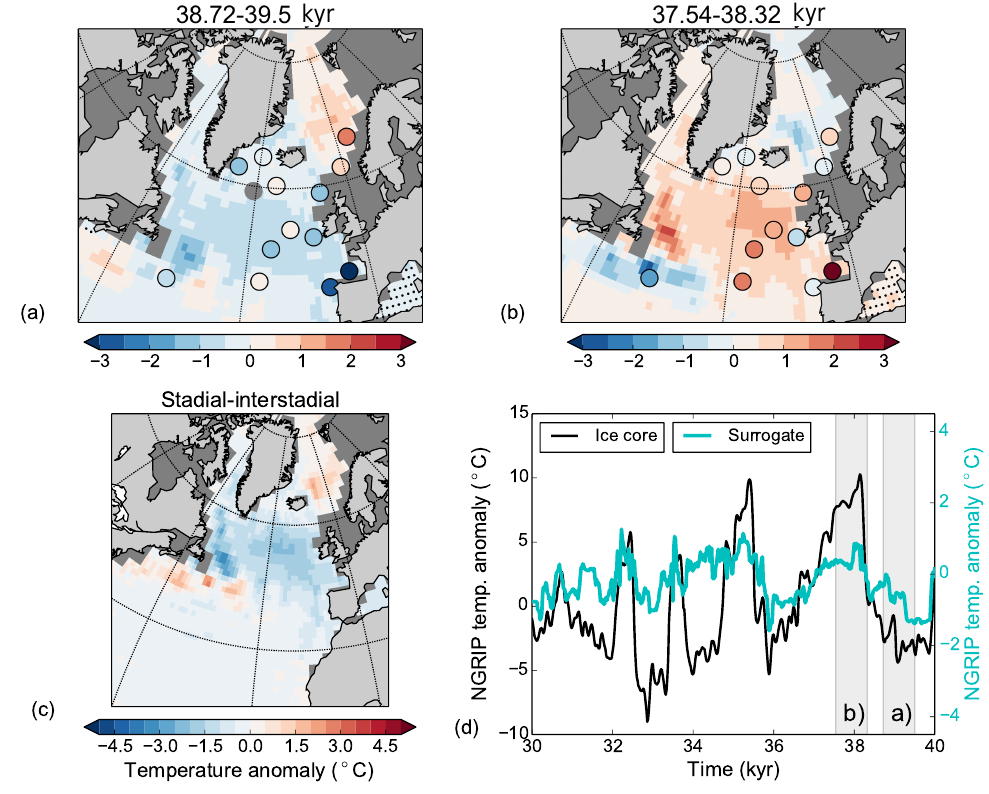
Figure 8. Same as Fig. 7 but for HadCM3